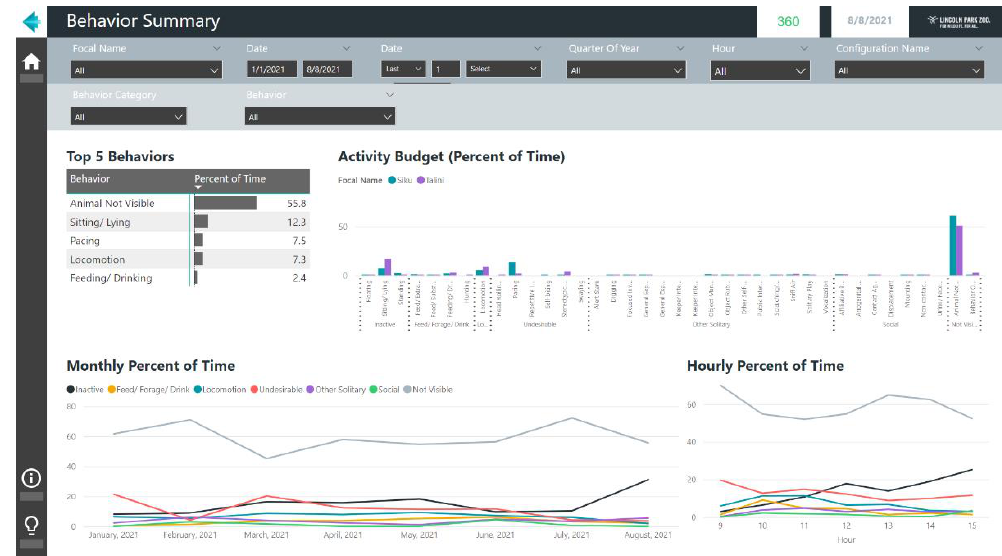
Figure 2. An example screenshot of a report in the Microsoft Power BI software.